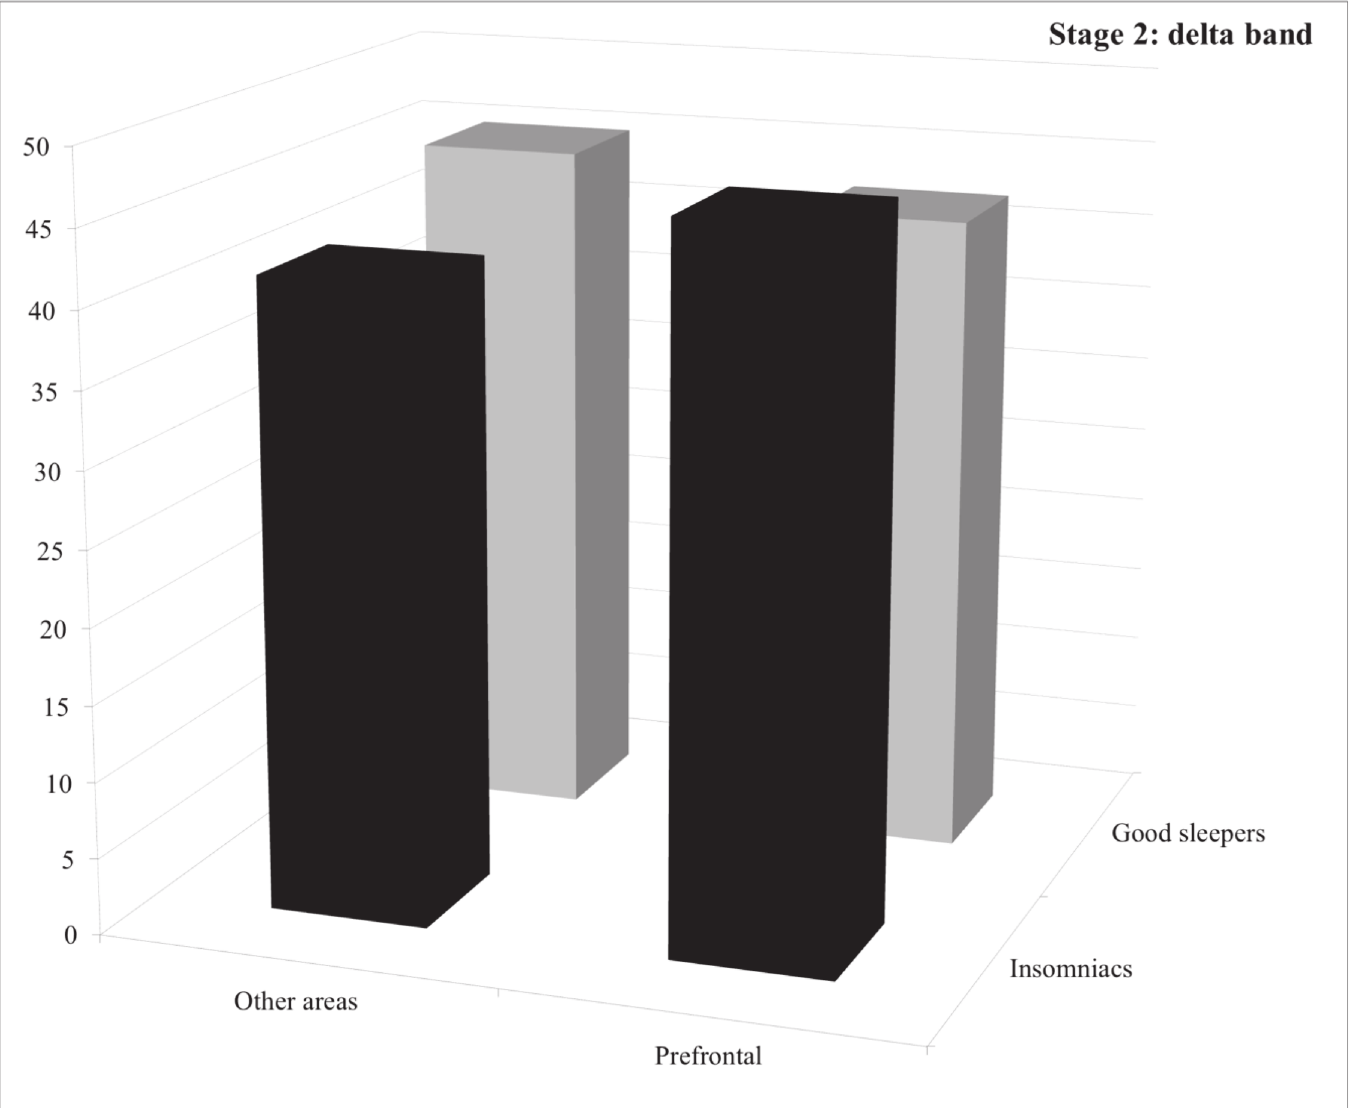
Figure 1. Relative power spectra for the delta band during stage 2 for both groups (insomnia patients and good sleepers) and each areas (others vs prefrontal). ** p <